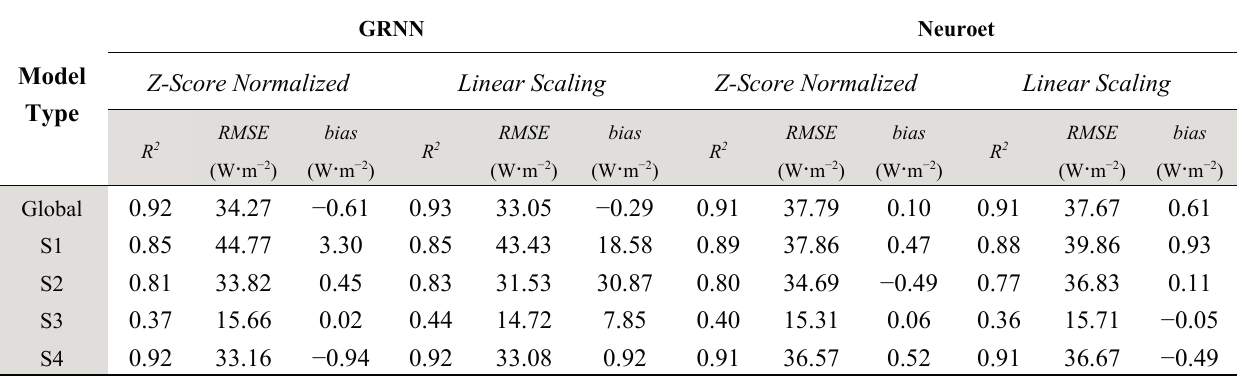
Table 8. Comparison of observed versus predicted R n with Z-score normalization and linear scaling method for GRNN and Neuroet global and S1-S4 conditional